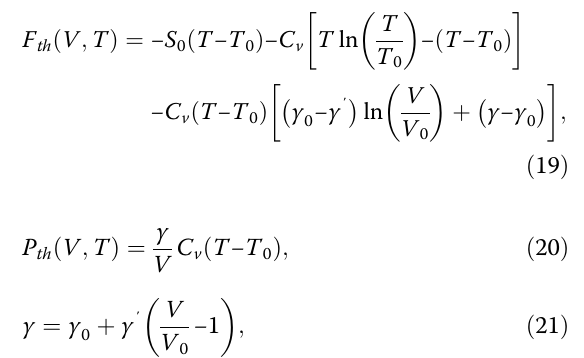
Additional file 1: Figure S5 shows the XRD patterns of the run products. Intense peaks from Re were unavoidably ob- served in all the patterns due to the small sample sizes in this study. Peaks from bridgmanite were evidently ob- served in OS3097 and OS3099, indicating that the experi- ments were performed outside of the garnet stability region, which is consistent with a previous study that re- ported the phase transformation of a MgSiO -rich com- 3 position from garnet to bridgmanite at 22.4 GPa